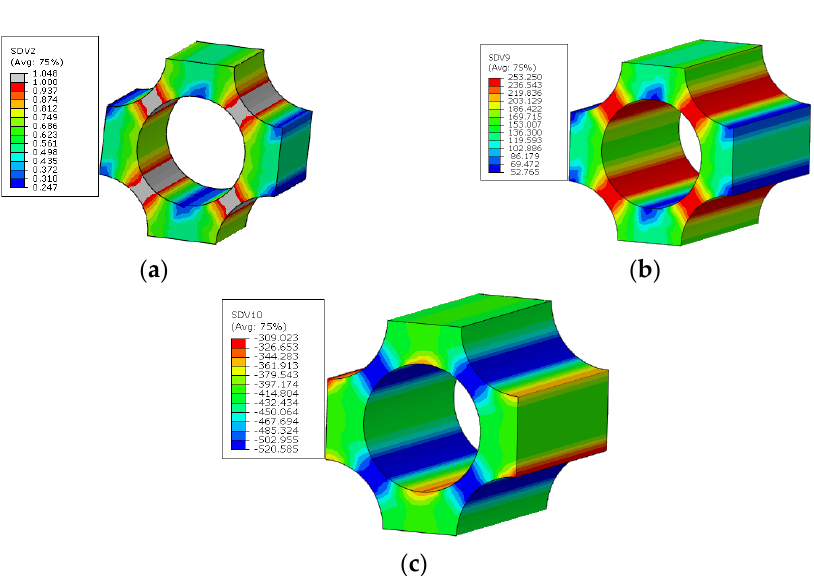
Figure 22. Failure indices and stress states in the matrix for fiber diamond distribution model. ( a ) failure indices; ( b ) equivalent stress; ( c ) first stress invariant.